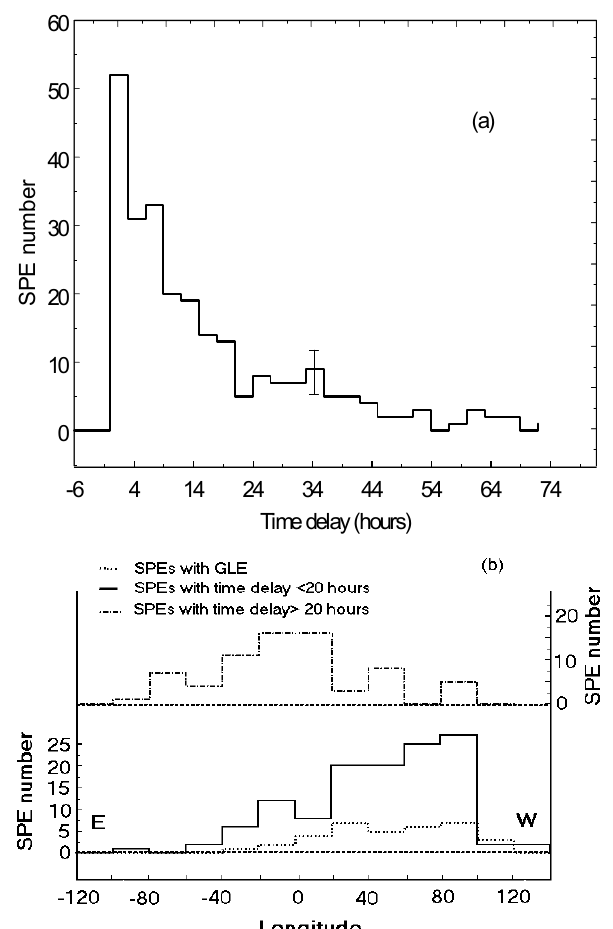
Fig. 7. ( a ) The SPEs number with respect the time delay between the proton event maximum and the onset time of the Ha “associated flares” is presented. ( b ) The longitudinal distribution of the SPEs in three cases (with GLE, with time delay < 20h and with time delay > 20h) is also illustrated.